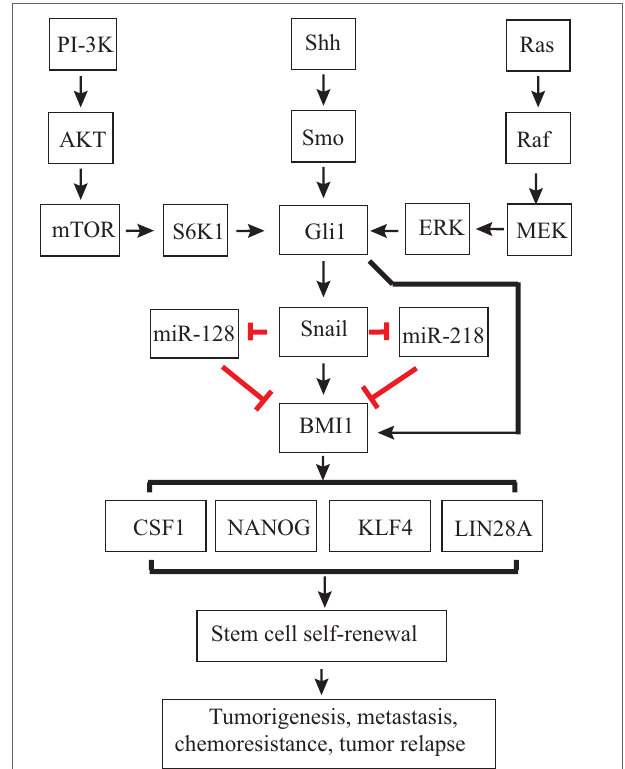
FiGURe 3 | Regulation of thyroid cancer stem cell (CSC) self-renewal by the sonic hedgehog (Shh) pathway. Canonical or non-canonical Gli activation induces Snail expression. Gli1 and Snail may directly induce Bmi1 expression or indirectly induce Bmi1 expression through miRNAs, such as miR-128 or miR-218. Bmi1 is a master regulator that controls the expression of several stem cell-related genes, such as Sox2 and Nanog, and CSC